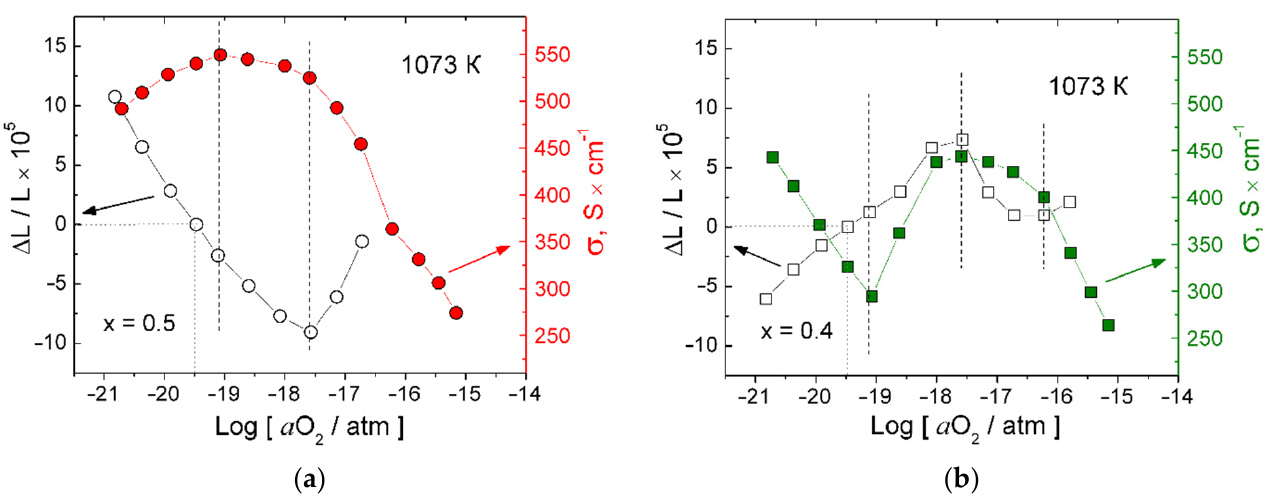
Figure 8. The dependencies of chemical expansion (left axes) and conductivity (right axes) on a O 2 at 1073 K for: CaV 0.5 Mo 0.5 O 3± δ ( a ) and CaV 0.6 Mo 0.4 O 3± δ ( b ).